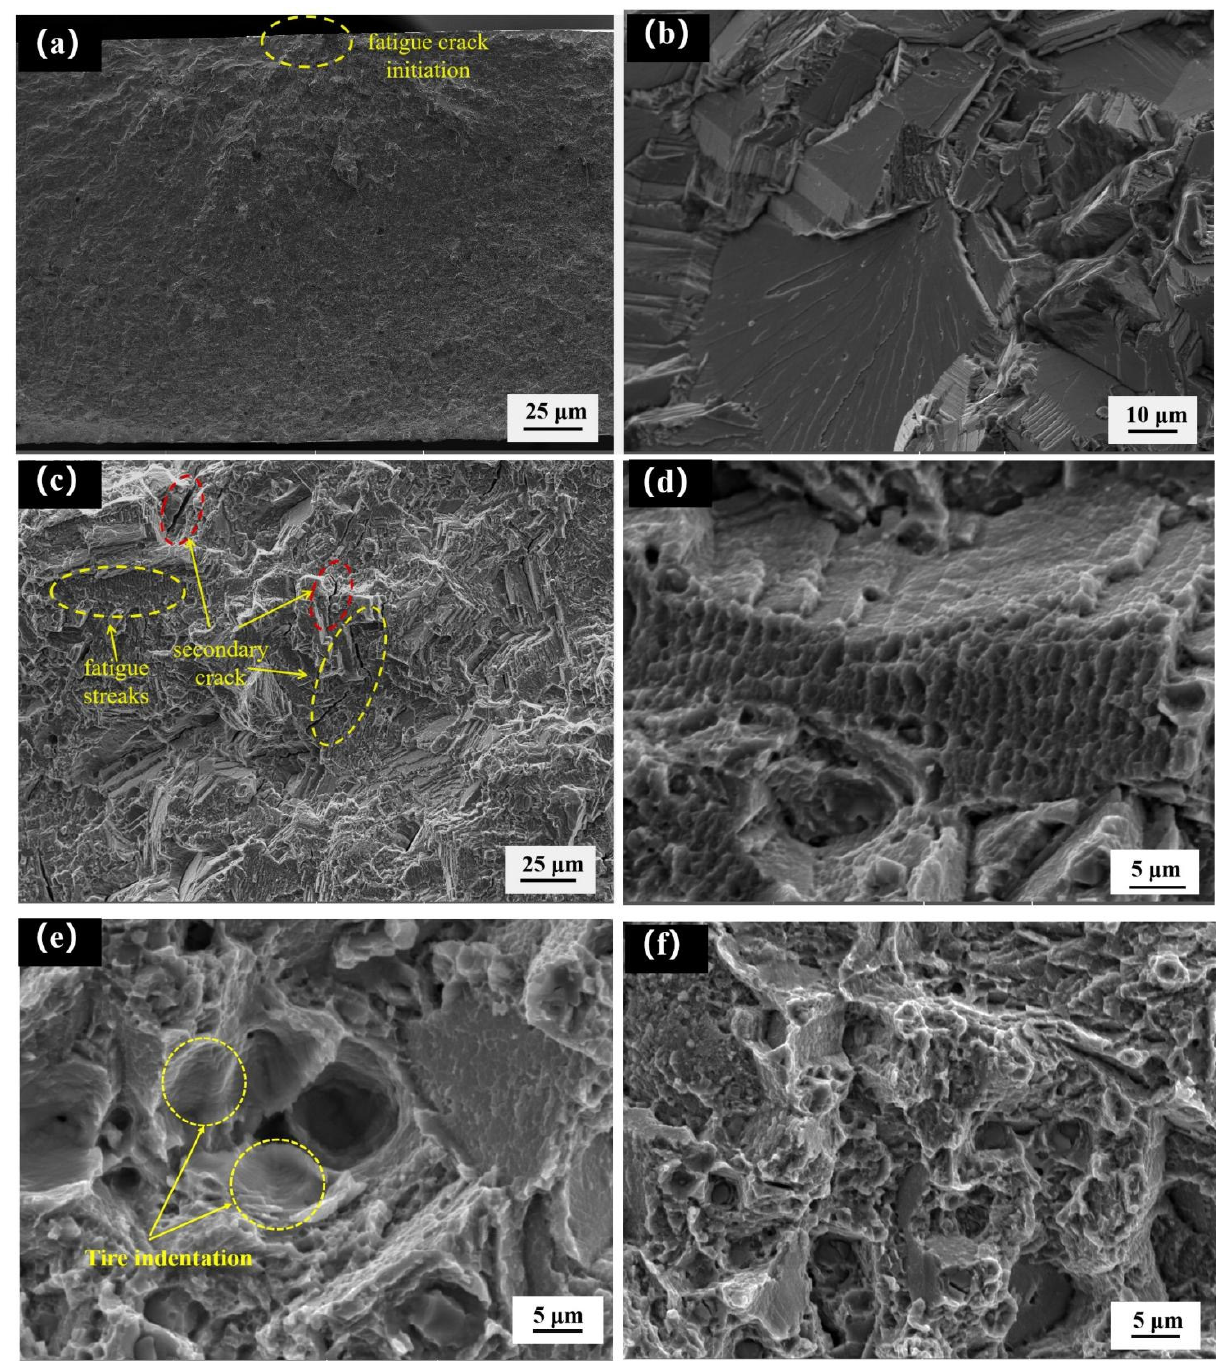
Figure 8. Fatigue fracture topography: ( a ) fatigue crack initiation, ( b ) cleavage step, ( c ) secondary cracks and fatigue streaks, ( d ) brittle fatigue streaks, ( e ) tire indentation, ( f ) dimples.